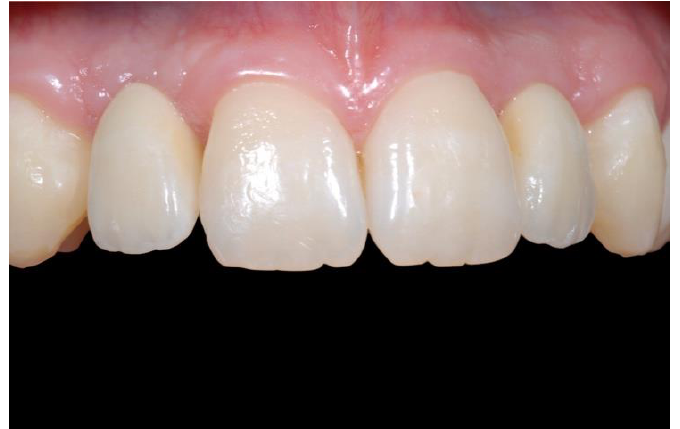
Figure 8. Post-operative front view 3 weeks after the cementation of the implant-supported zirconia single crowns onto the zirconia abutments in position 12 and 22.